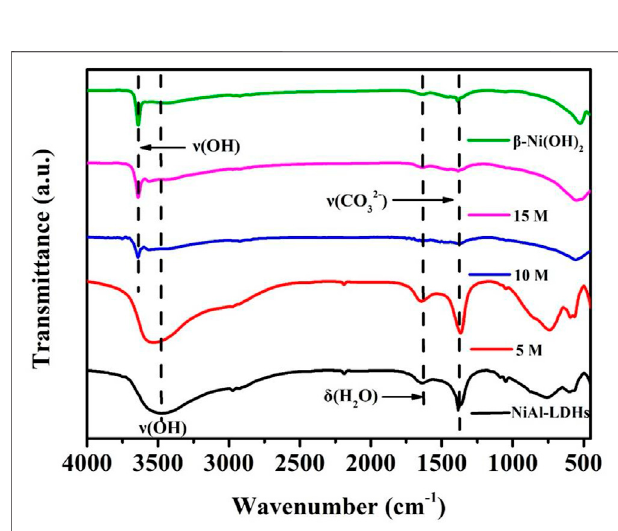
FIGURE 3 | FT-IR spectra of NiAl-LDHs precursor, the alkaline-etched samples in 5, 10, and 15 M KOH solution, and β -Ni(OH) 2 sample prepared by precipitation